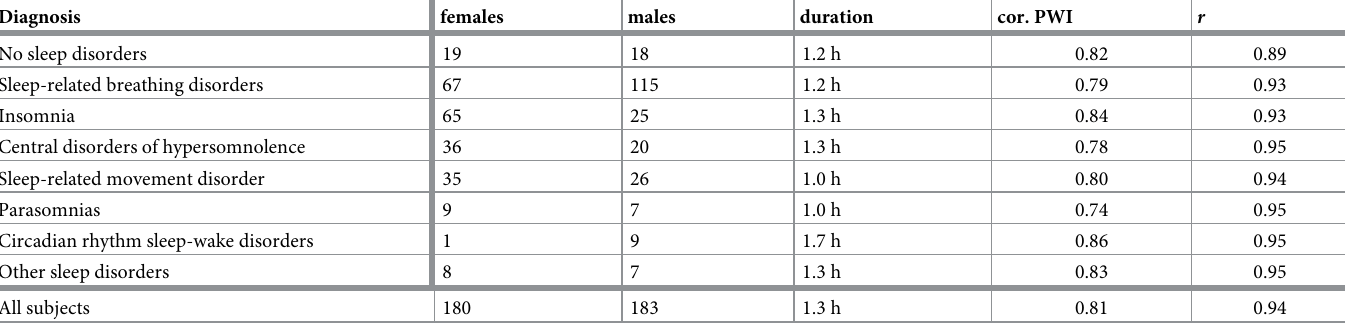
Table 1. Overview of all subjects included in the analysis. Subjects with multiple diagnoses are counted in each appropriate diagnosis line, i.e., multiple times. The last line reports data for all subjects irrespective of diagnosis. The column “duration” reports the median total duration (per subject) of all pulse wave intervals (PWI) correctly associated with corresponding heartbeat intervals from the ECG at an accuracy limit of 0.1 s (see Methods and also Table 2). It is followed by the median fraction of cor- rectly associated PWI and the corresponding median Pearson cross correlation r in the subsequent columns (see Results section for details).